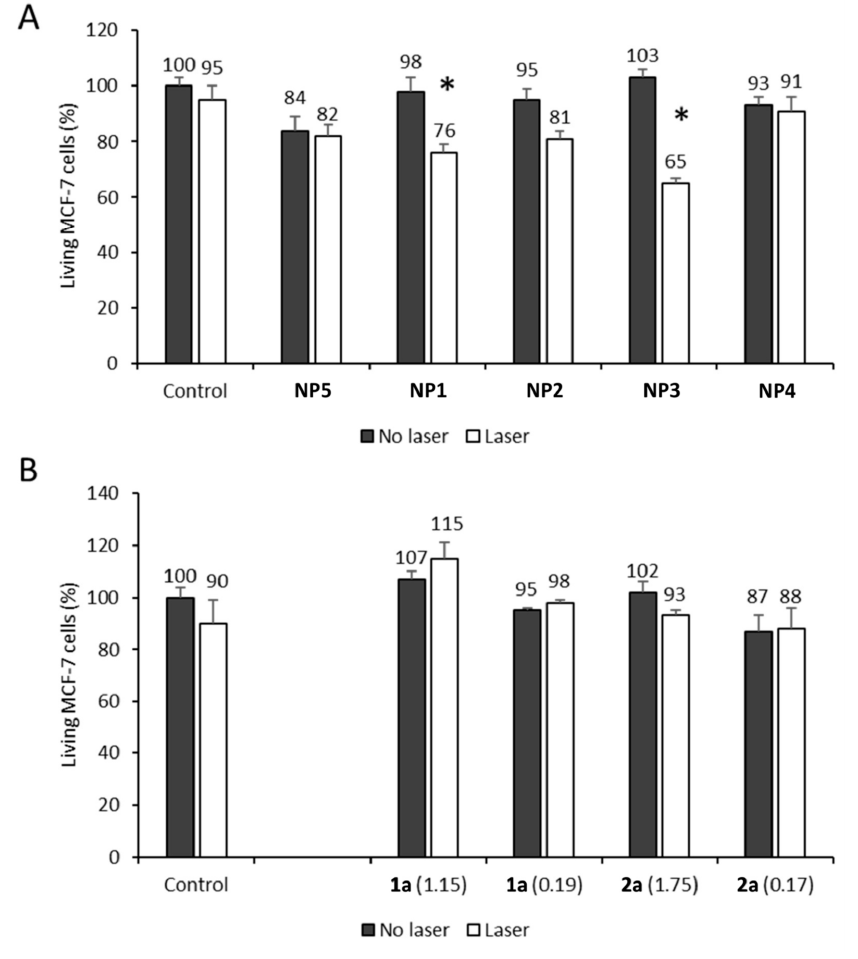
Figure 4. 2P-PDT efficacy of NP1-5 (25 µg·mL − 1 ) ( A ) and analogous TEG-ylated 1a and 2a at the same porphyrin concentrations ( B ) on MCF-7 cancer cells, upon irradiation with a Chameleon pulsed laser at 790 nm. Values are means ± standard deviations. *: p values < 0.05 (meaning that cell survival measured under irradiated conditions is significantly different from that obtained without irradia- tion).